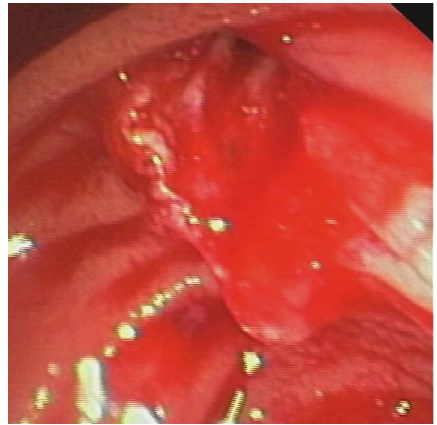
Figure 7: Severe bleeding from the upper margin of the sphinctero- tomy